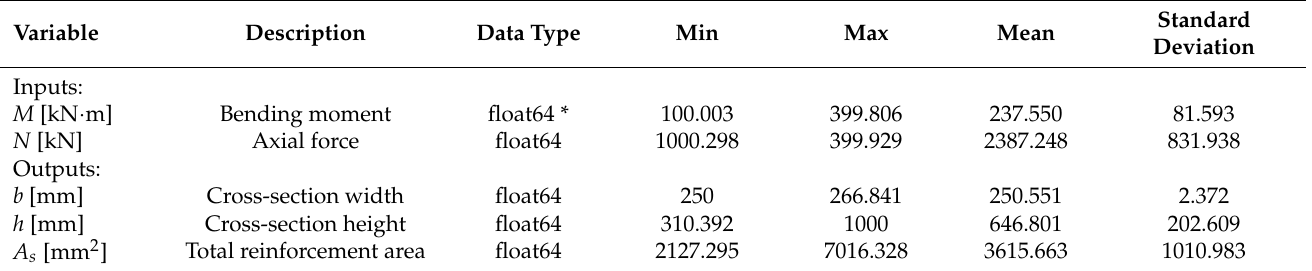
Table 3. Descriptive and statistical features of the inputs and outputs.